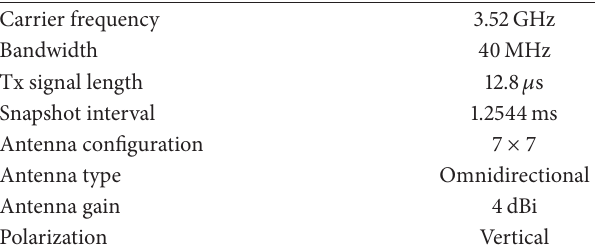
Table 1: The configurations of THU MIMO channel